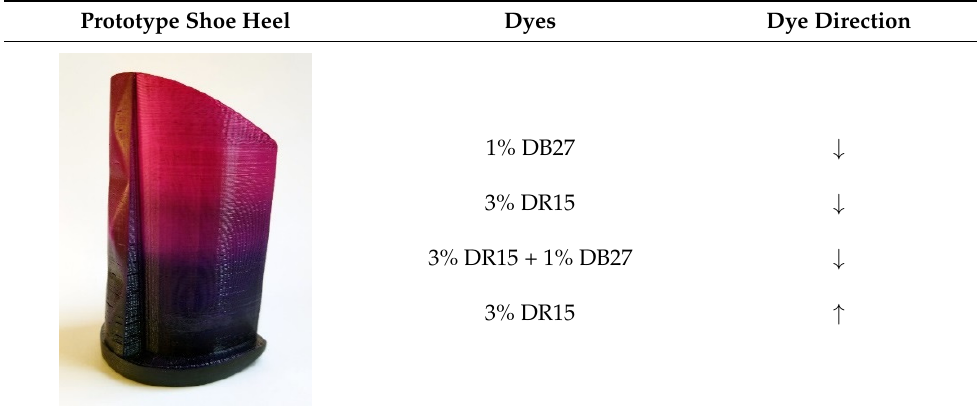
Table 11. Heel prototype obtained with a mixture of dyes with an ombre effect. Prototype Shoe Heel